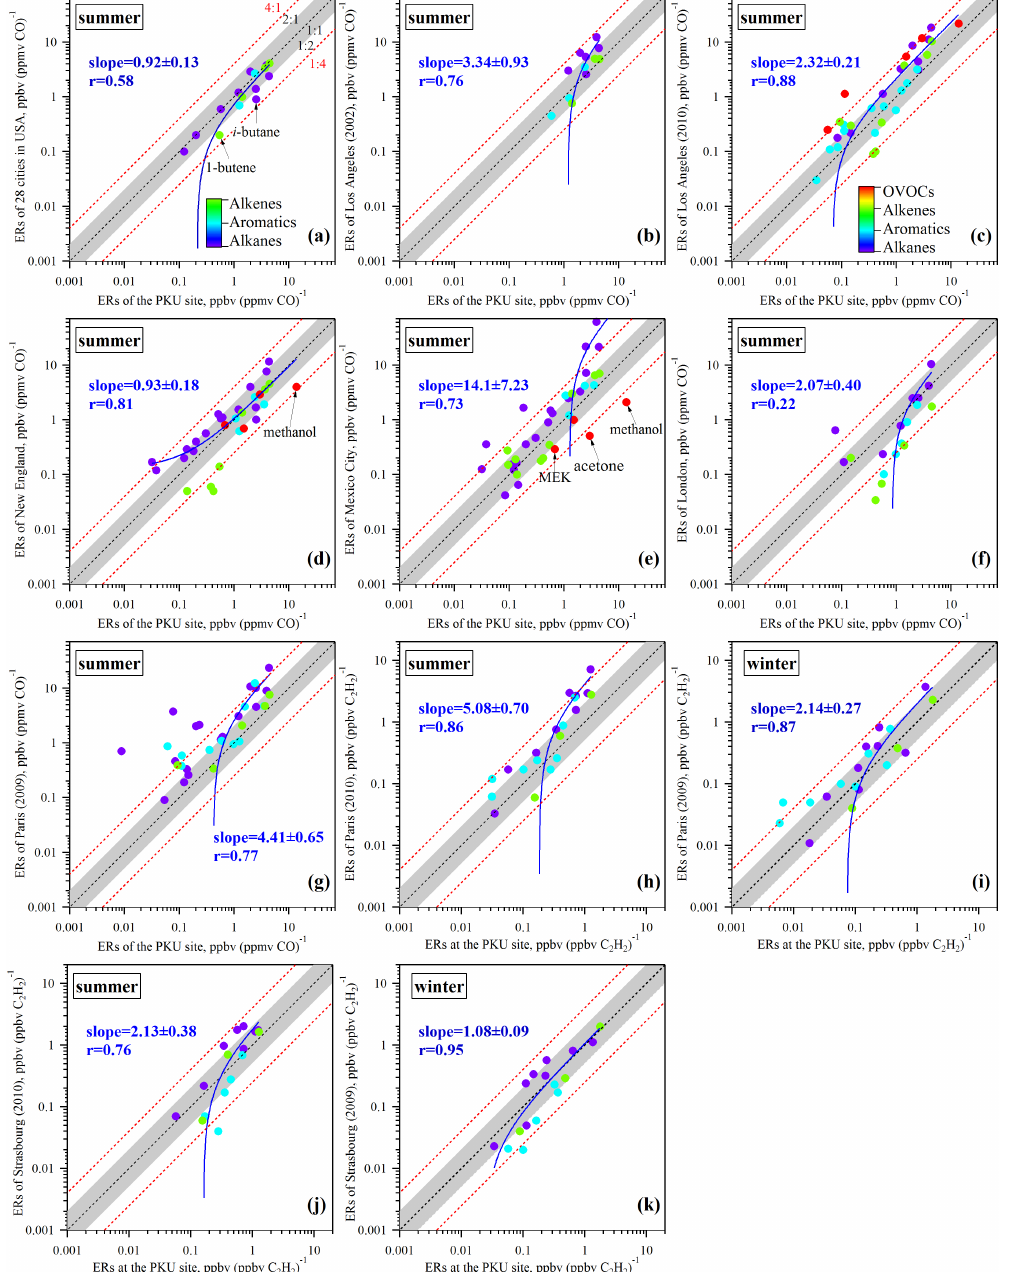
Figure 9. Comparisons of VOC emission ratios determined at the PKU site with those for (a) 28 US cities (Baker et al., 2008); (b) Los Angeles, US (Warneke et al., 2007; Borbon et al., 2013); (d) New York City and Boston, US (Warneke et al., 2007); (e) Mexico City, Mexico (Bon et al., 2011); (f) London, UK (McMeeking et al., 2012); (g–i) Paris, France (Borbon et al., 2013; Boynard et al., 2014); and (j–k) Strasbourg, France (Boynard et al.,